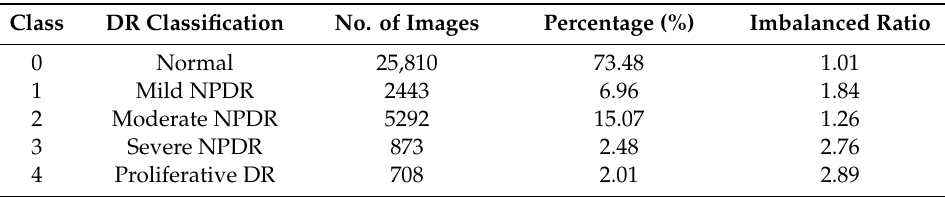
Table 3. DR fundus images distribution.